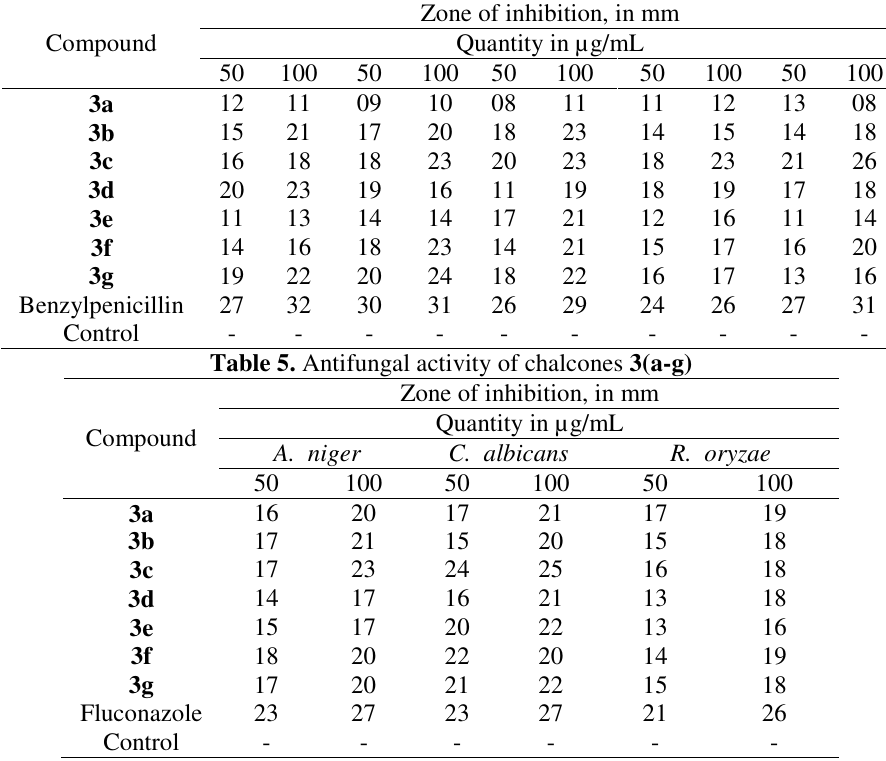
Table 5. Antifungal activity of chalcones